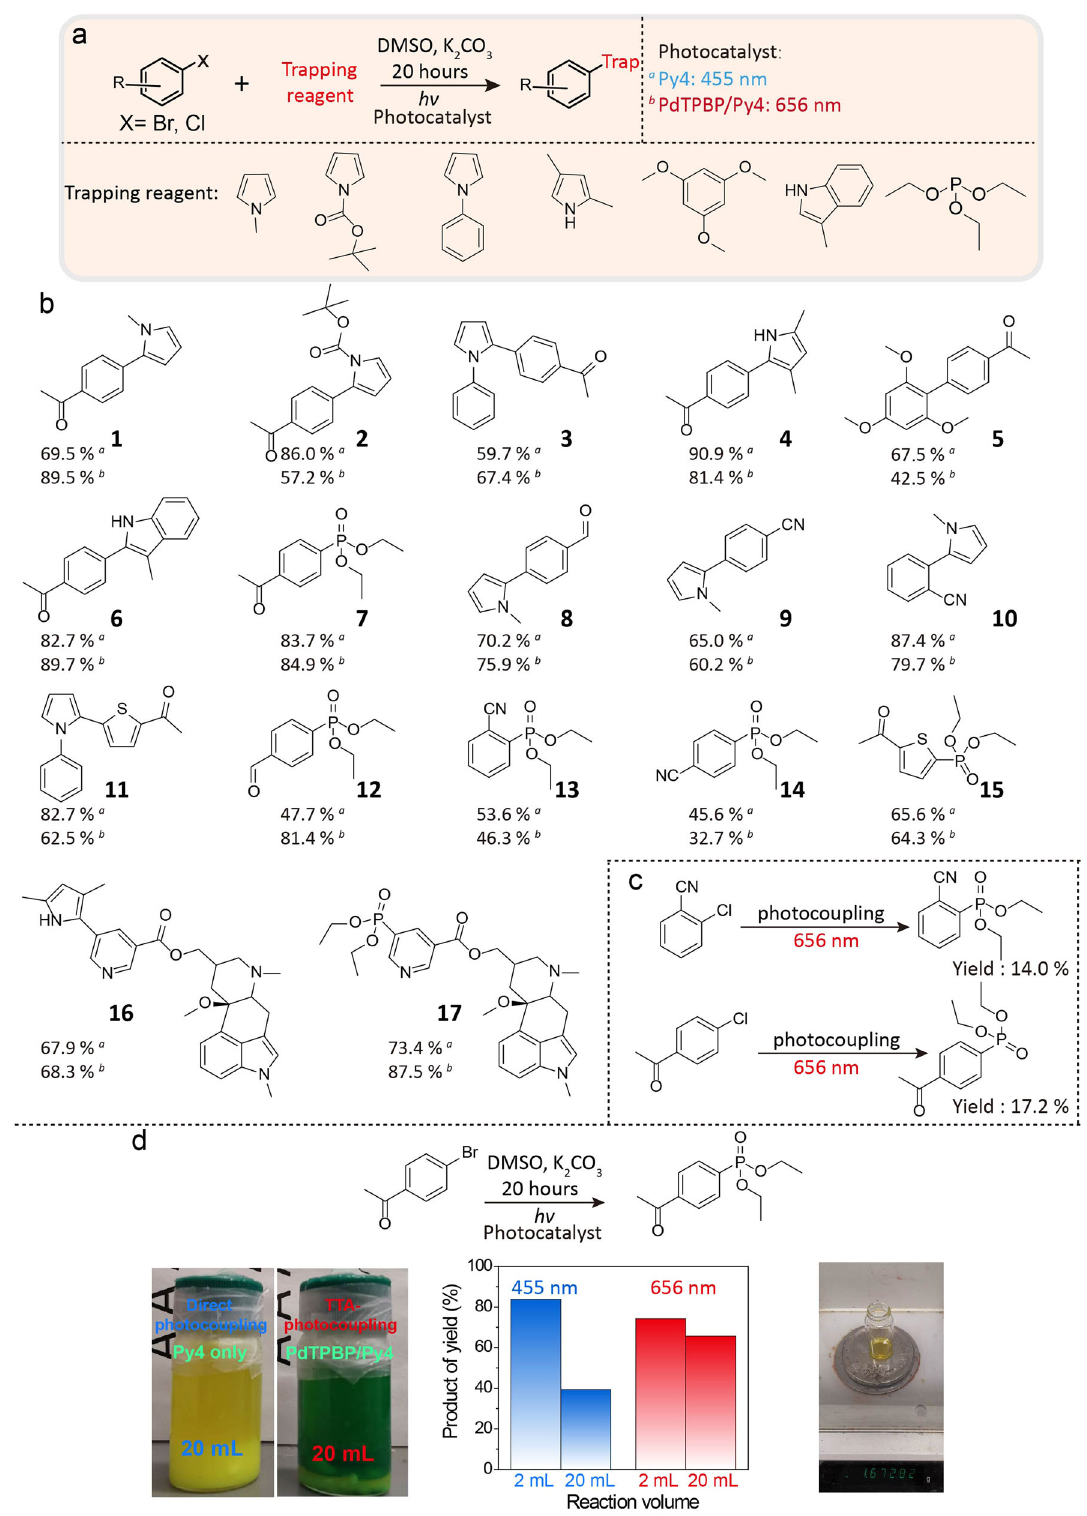
Fig. 4 | Substrate scope of the red light-driven photoactivation of aryl halides via a TTA mechanism to give coupling products. a The reaction formula of the investigated photocoupling between inert aryl halides with various trapping agents. b Photocoupling products for aryl bromides and the relative yields. c Photocoupling between aryl chlorides and triethyl phosphite. d The